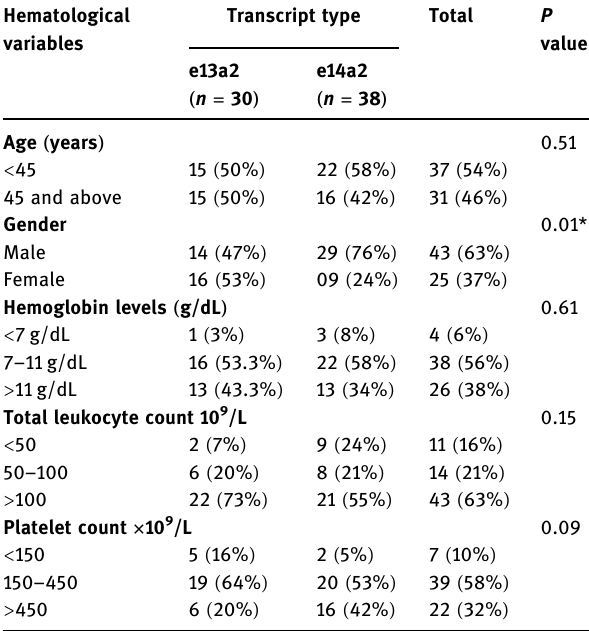
Table 2: Characteristics of the CML patients with e13a2 and e14a2